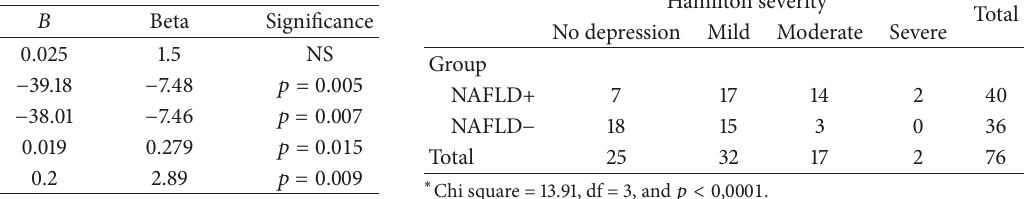
Table 2: Pierson’s correlation of MoCA score values and observed volumes.